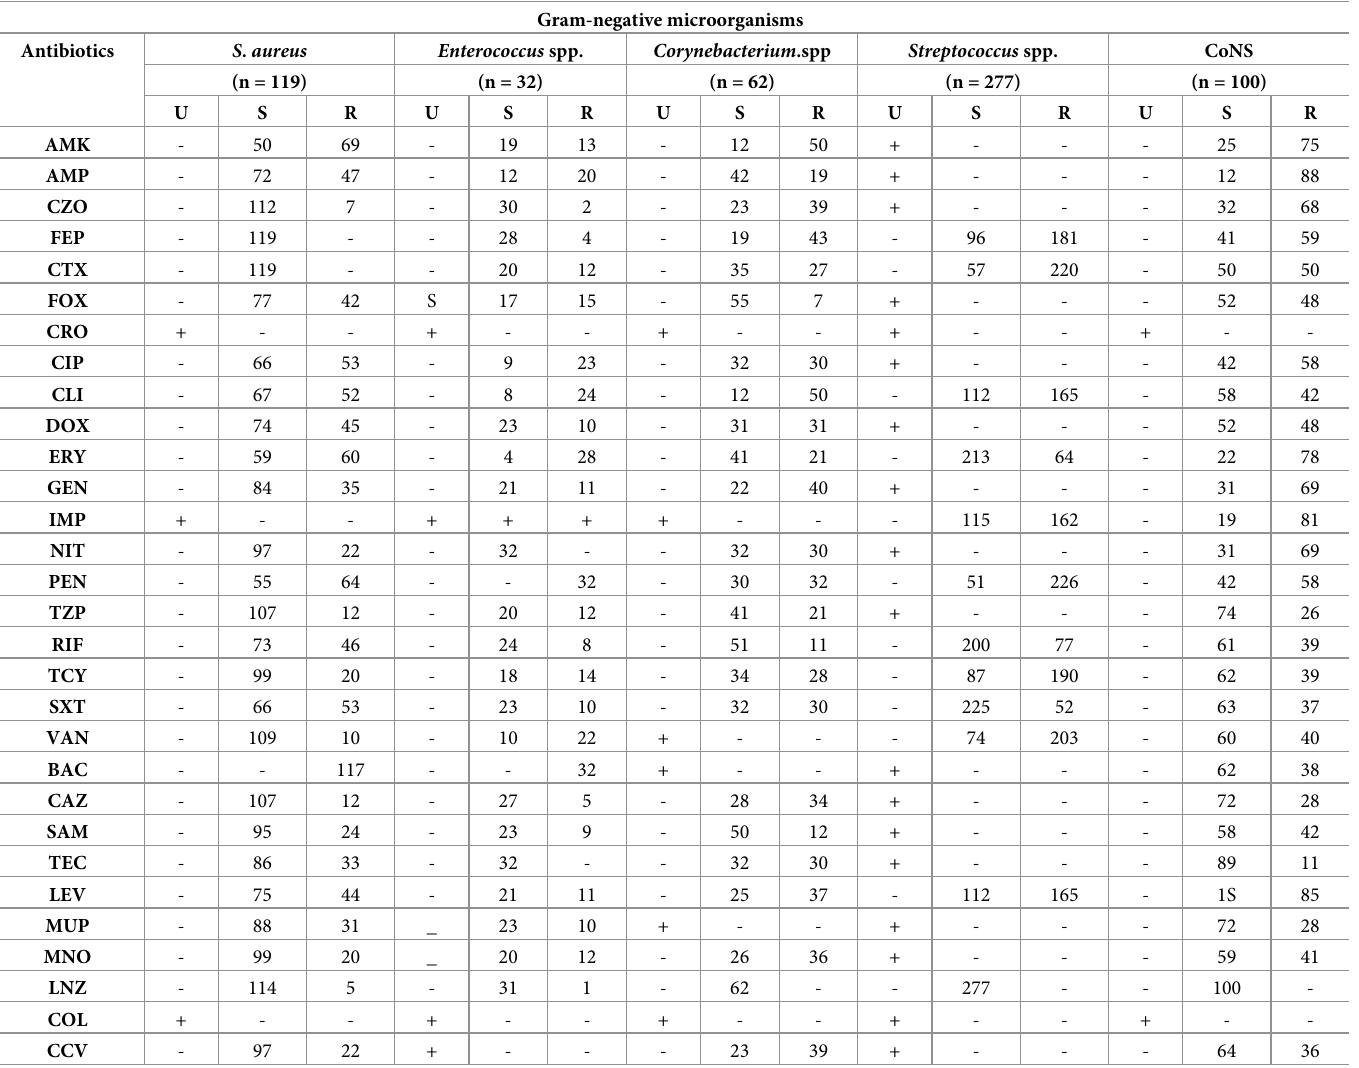
Table 2. Antibiotic resistance pattern for Gram-positive bacteria.